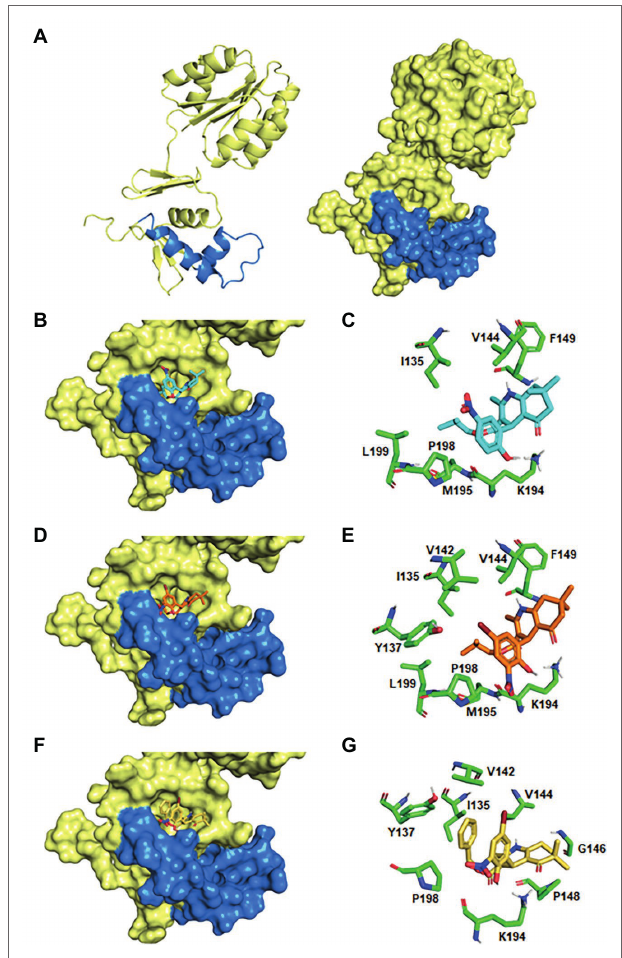
FIGURE 5 | Predicted models of HsrA-DHP interactions. (A) Ribbon diagram and molecular surface of an HsrA monomer. The helix-turn-helix (HTH) DNA binding motif in the C-terminal domain has been highlighted in blue. (B,D,F) 3D views of the best-ranked docking poses of MD1, MD7, and HM6. (C,E,G) Detailed views of the HsrA amino acid residues involved in the interaction with the respective